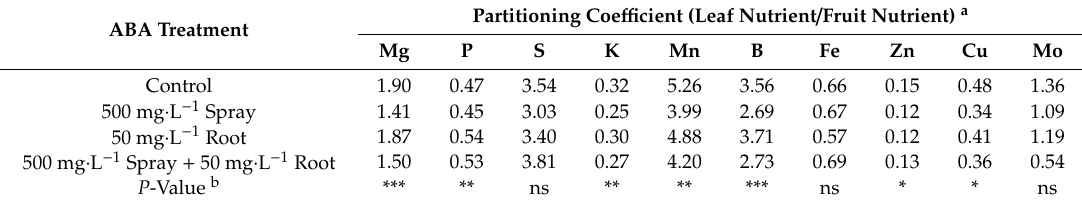
Table 3. Mineral nutrient partitioning coe ffi cient for leaf to fruit ratio of nutrients in ‘Mt. Fresh Plus’ tomato plants grown in a greenhouse and treated with exogenous applications of abscisic acid